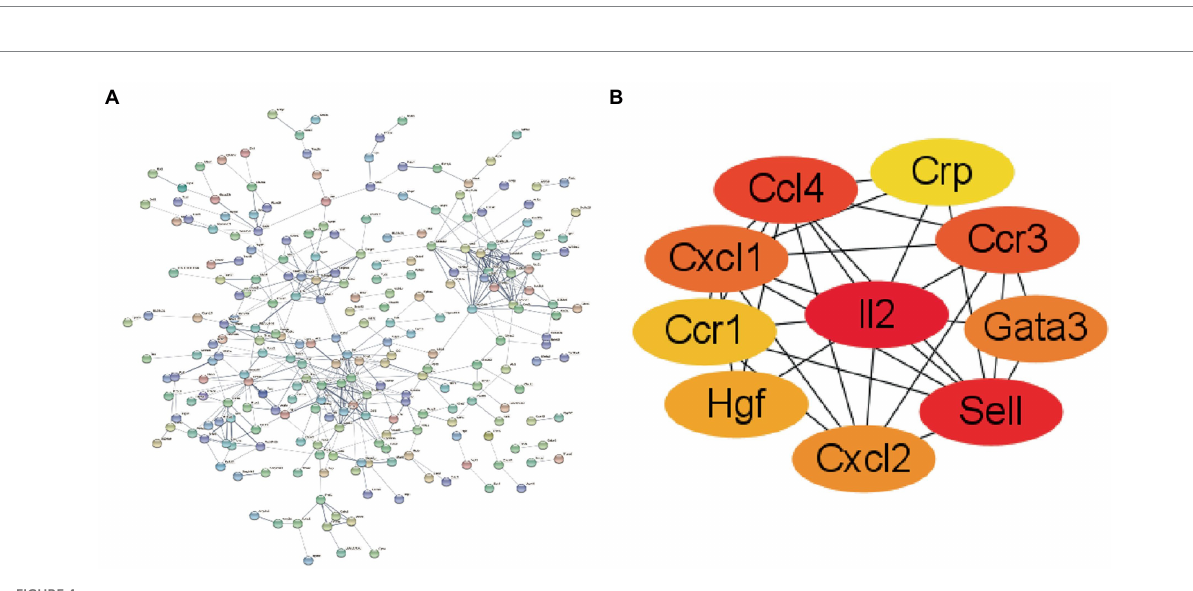
FIGURE 4 The construction of PPI network. (A) PPI network of overlapping hub genes. (B) The core genes of the interaction network were obtained by degree